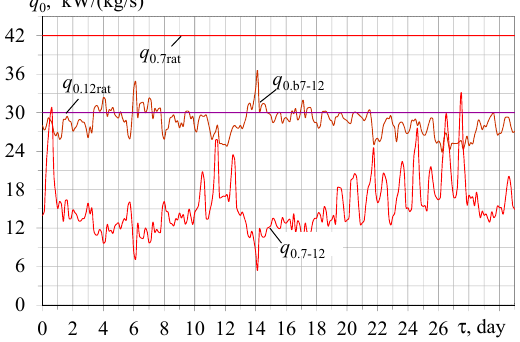
Figure 13. Actual values of refrigeration capacities q 0.7–12 for air conditioning from 12 to 7 ◦ C and residual booster values q 0.b7–12 ; relative booster refrigeration capacities values q 0.b7–12 / q 0.7rat for air conditioning to target temperature 7 ◦ C at the threshold temperature 12 ◦ C: q 0.b7–12 = q 0.7rat − q 0.12 ; q 0.7–12 = q 0.7 − q 0.12 .